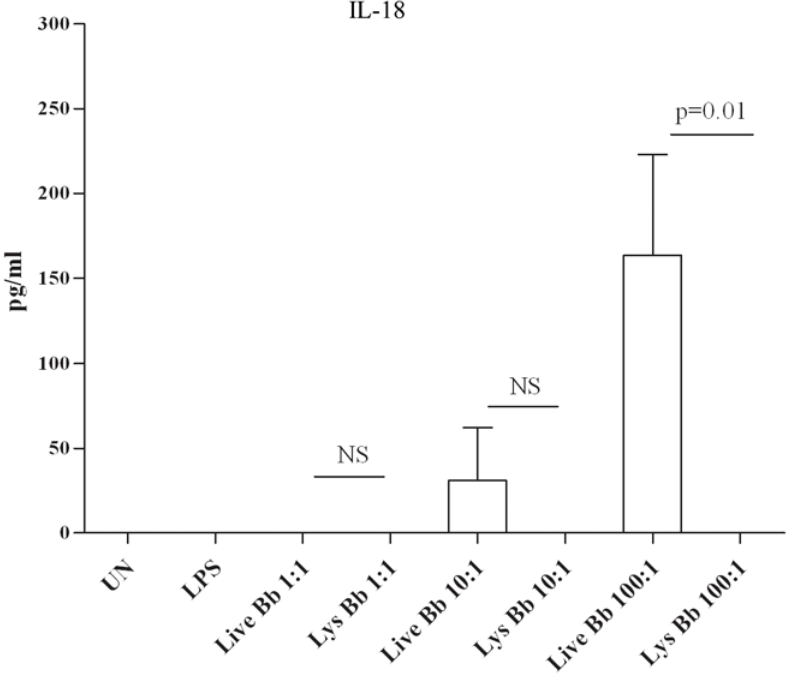
Figure 3. IL-18 is secreted in response to live Bb but not lysates. Monocytes were either unstimulated or incubated with live or lysed Bb at various MOIs (1:10:100) and 100 ng/ml lipopolysacharide (LPS). Secreted IL-18 was determined by ELISA as described in the Methods. Bars depict the mean value (pg/ml) + / 2 standard error of the mean from three independent experiments. P-values calculated for comparative cytokine production between cells stimulated by live and lysed Bb at equivalent MOI are shown above the corresponding bars. NS=not significant.